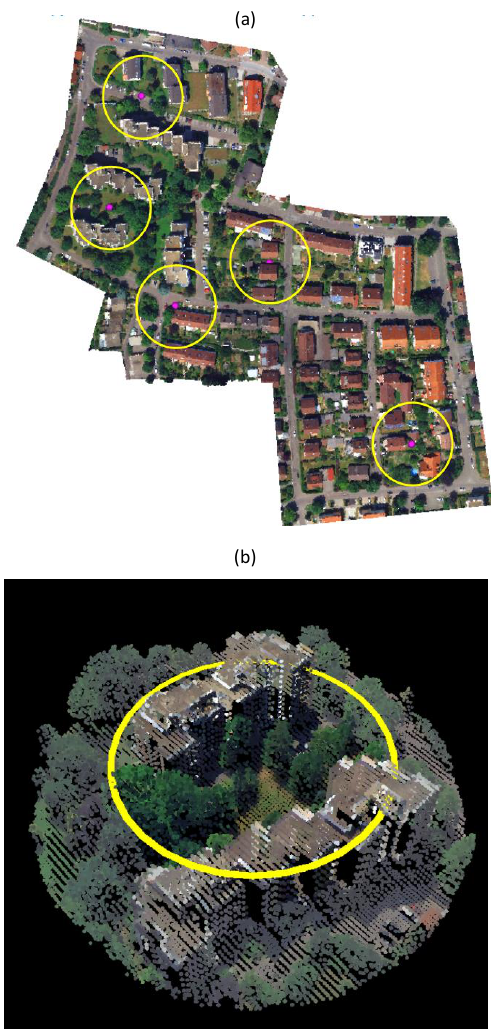
Figure 1. Overview (a) and example of one section (b) of the